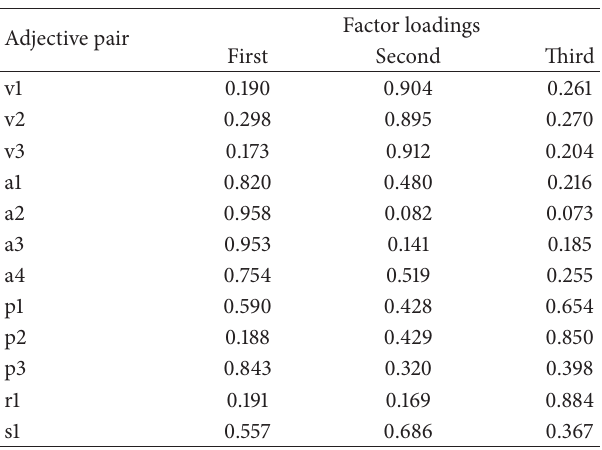
Table 4: Factor loadings.